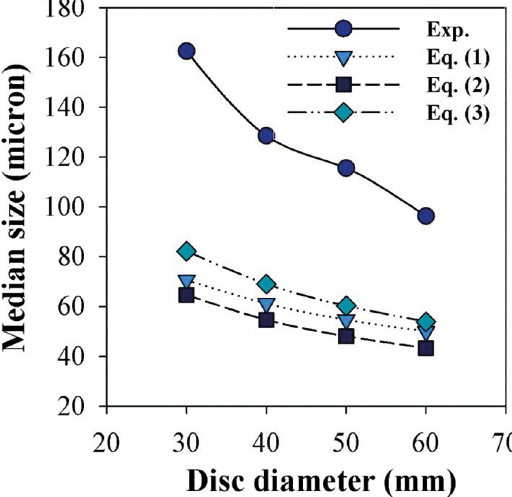
Figure 5. Effect of atomising disc diameter on median particle size. Rotating speed 30,000 rpm, 50 kg/hr melt feed rate, and 550 o C melt temperature.